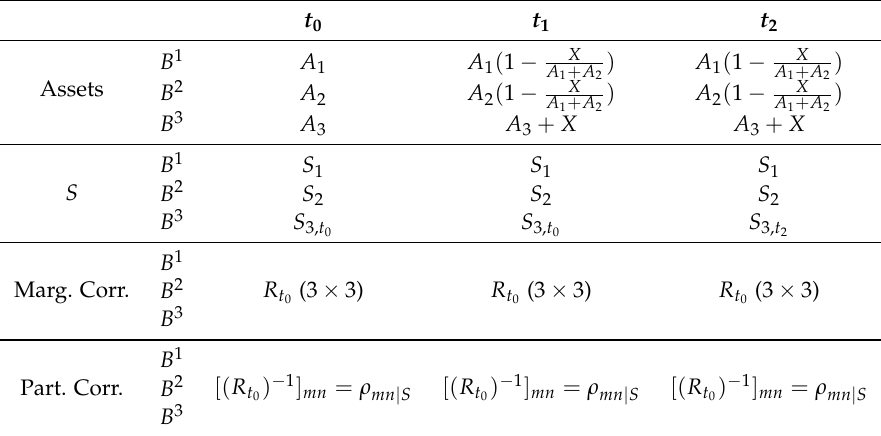
Table 2. Variables’ time-evolution, private intervention. t 1 t